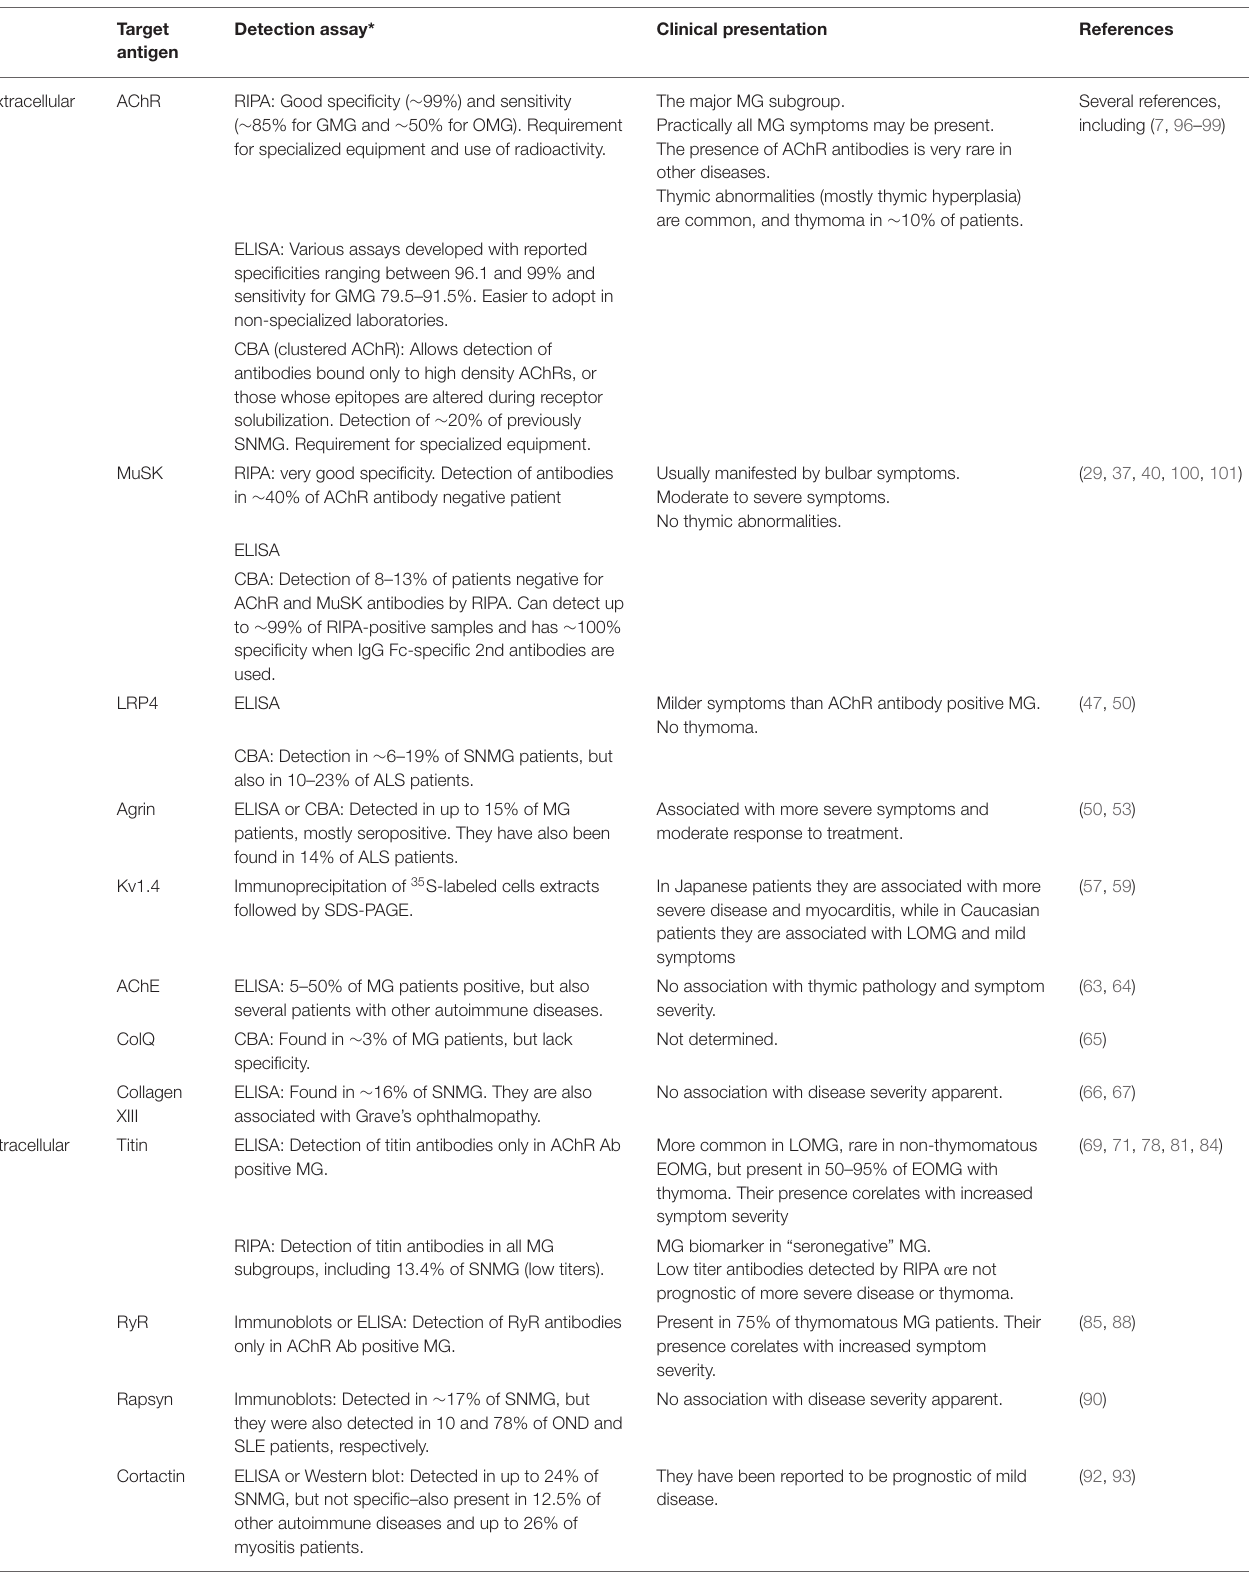
TABLE 1 | Autoantibody specificities in MG with clinical associations and common detection assays used. Target Detection assay* Clinical presentation antigen